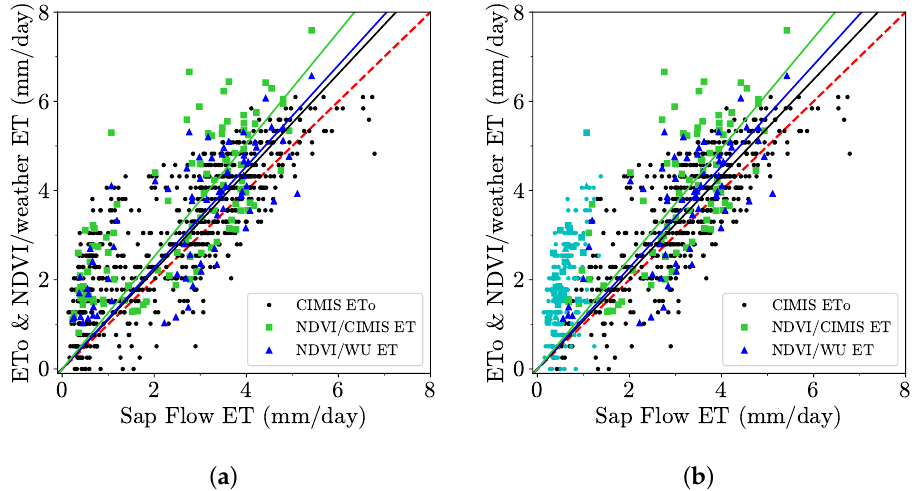
Figure 10. Scatter plots of ET o and NDVI/weather-based ET versus sap flow-based ET with winter data in ( a ), and without winter data in ( b ) (the removed winter data are highlighted in cyan). The red line represents the 1:1